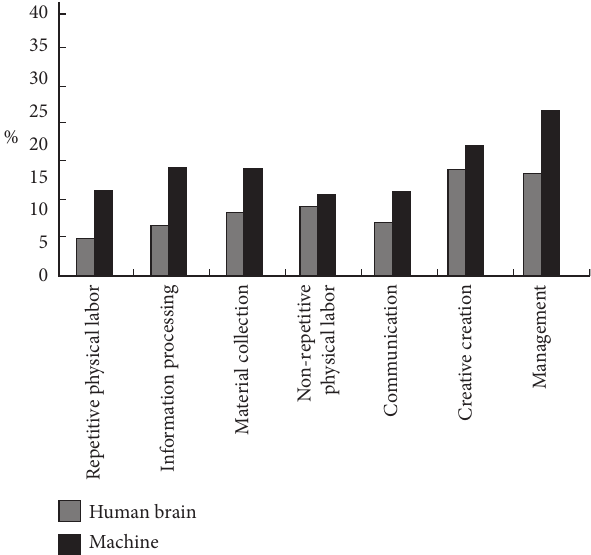
Figure 4: The distribution ratio of the designer’s working hours in a